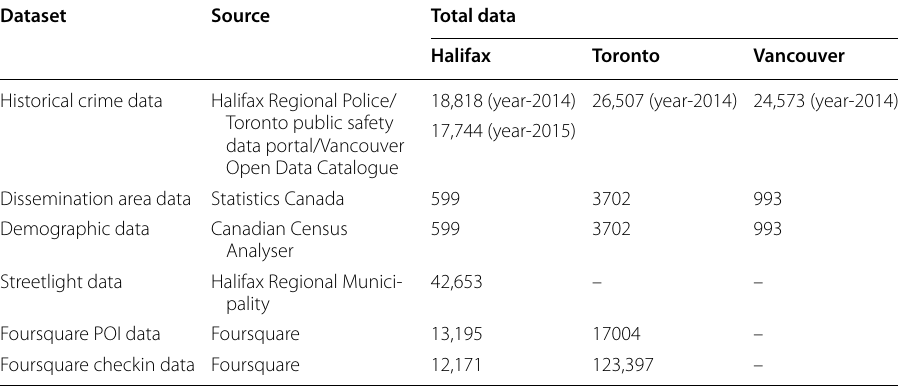
Table 1 Details of the datasets used for the experiments